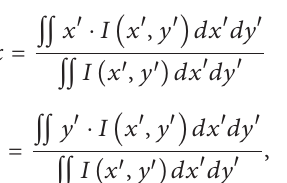
(𝑥, 𝑦) : From Figure 10, the center of an RPRA’s blurred image indicates the position of the scattering center. So, (𝑥, 𝑦) can be estimated, respectively,